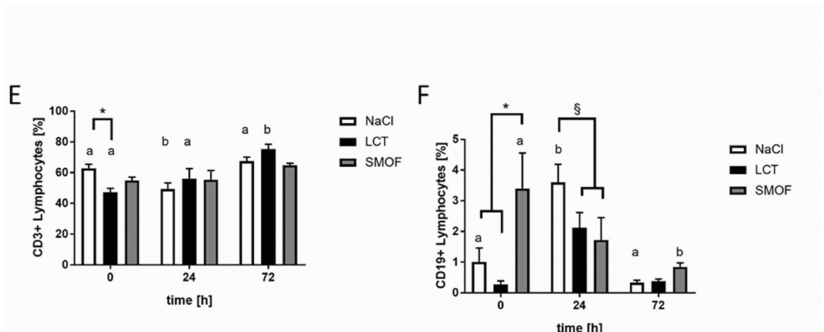
Figure 2. E ff ect of lipid emulsions on alveolar recruitment of leukocyte subtypes in LPS-induced acute respiratory distress syndrome. ( A ): At both 24 h and 72 h after induction of ARDS, the SMOF mouse group showed the lowest number of alveolar leukocytes compared to the NaCl and LCT groups (*, p < 0.01). ( B ): After 72 h of LPS stimulation, the NaCl group displayed the lowest fraction of alveolar M φ -type cells compared to animals receiving LEs (*, p < 0.01). ( C ): After 72 h, mice receiving NaCl showed the highest BAL content of PMNs compared to other groups (*, p < 0.01). ( D ): The NaCl group showed significantly reduced lymphocytes compared to the other groups 72 h after LPS instillation (*, p < 0.01). ( E ): In unstimulated mice, CD3 + lymphocytes were reduced in the LCT group compared to NaCl (*, p < 0.01). ( F ): After 24 h, the highest proportion of CD19 + lymphocytes was in NaCl mice compared to LCT and SMOF mice (§, p <